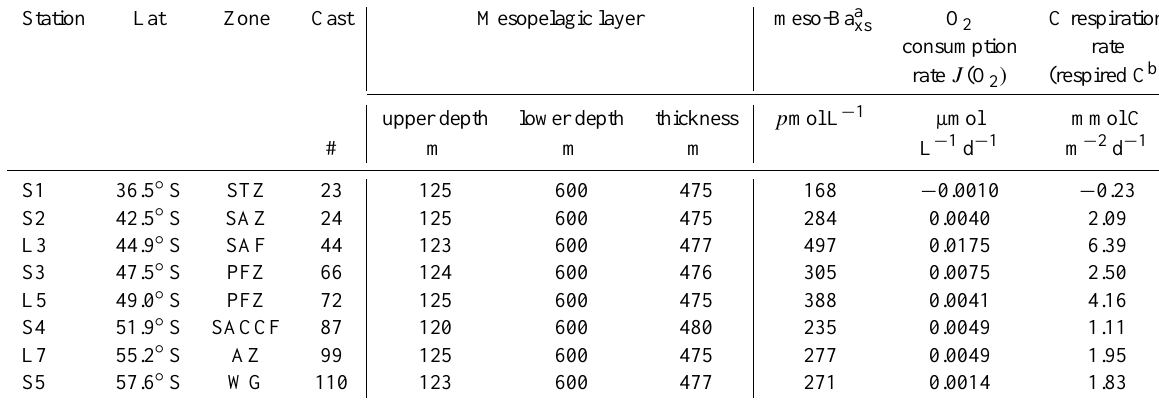
Table 4. Remineralisation fluxes in mesopelagic waters, based on Ba xs contents and Eq. (2). Also listed are mesopelagic layer thickness, depth-weighted average mesopelagic Ba xs contents; calculated average O 2 consumption rates (µmolL − 1 ) and column integrated respired C in mmolCm − 2 d − 1